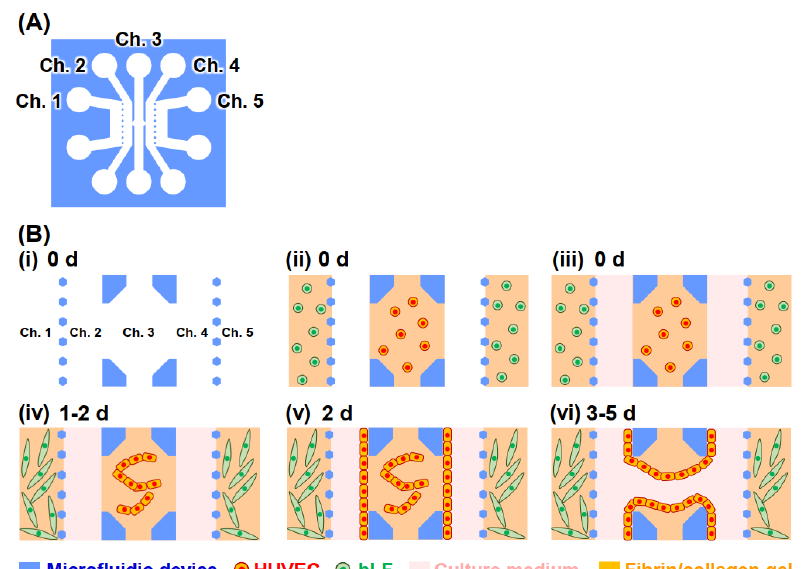
Figure 2. Fabrication of the vascular vessel models. ( A ) Device outline. ( B ) Cell culturing. (i)–(iv) HUVECs were cultured in gel in Ch. 3 for vasculogenesis. (v)–(vi) Additional HUVECs were seeded onto the gel sidewalls to prepare monolayers and were cultured for angiogenesis. Not to scale. Although only a simple vessel is illustrated here, in actuality a network of vessels is formed.